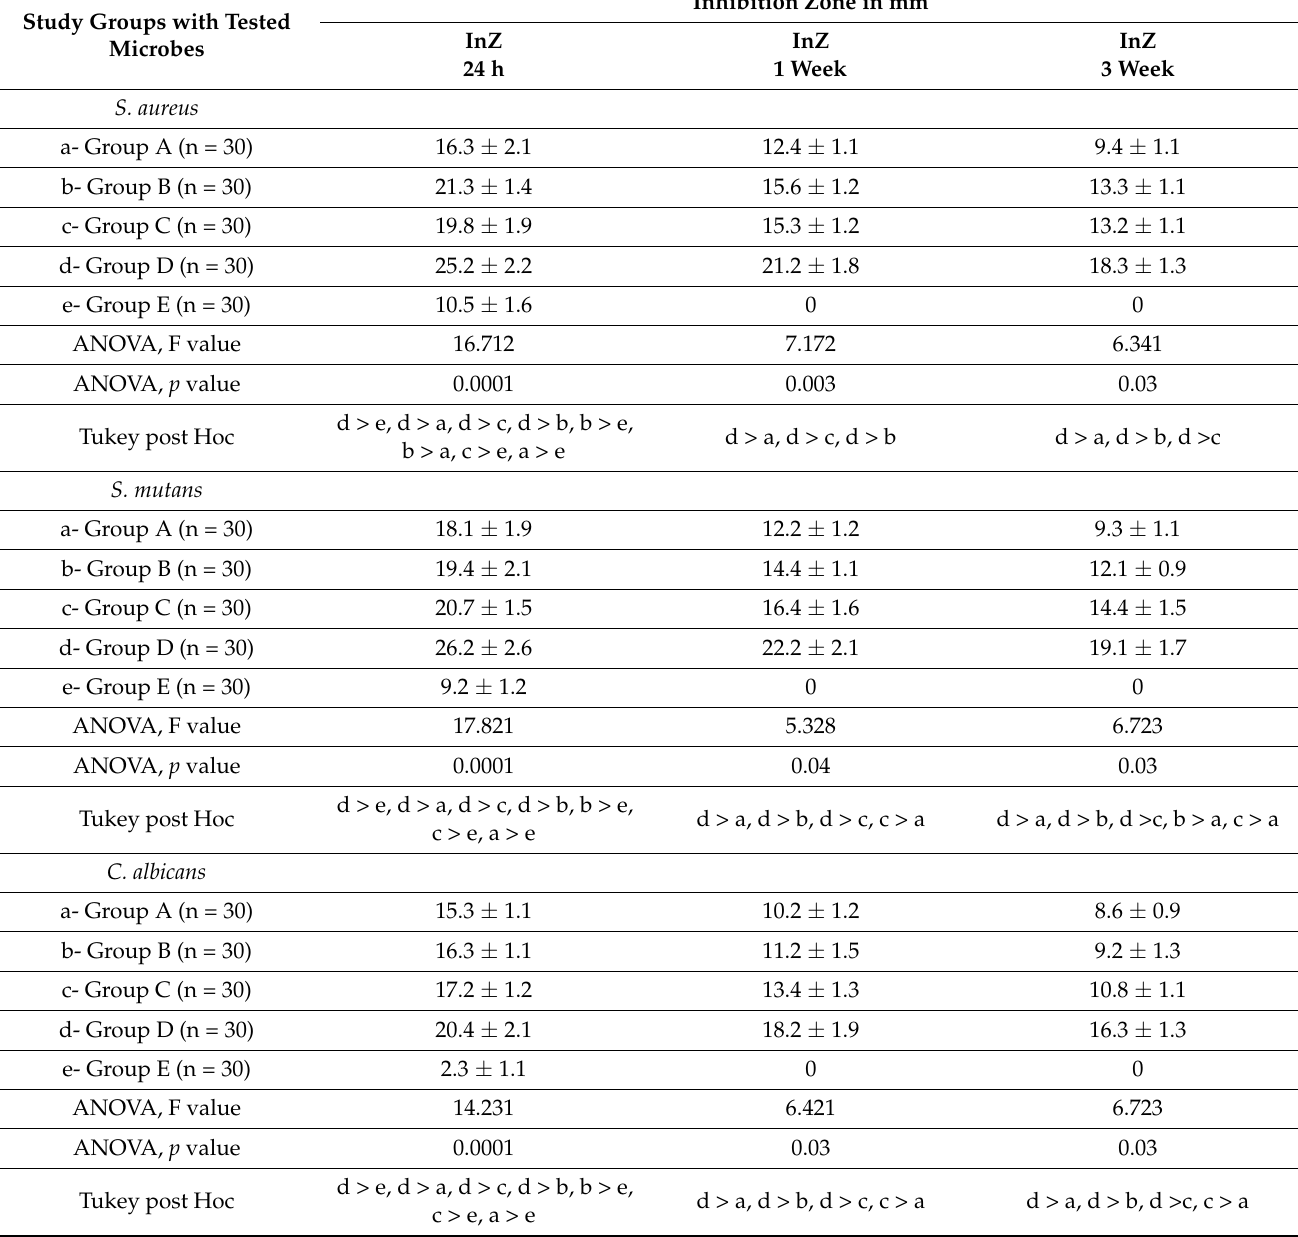
Table 1. Antimicrobial efficacy of tested GIC specimens at different time